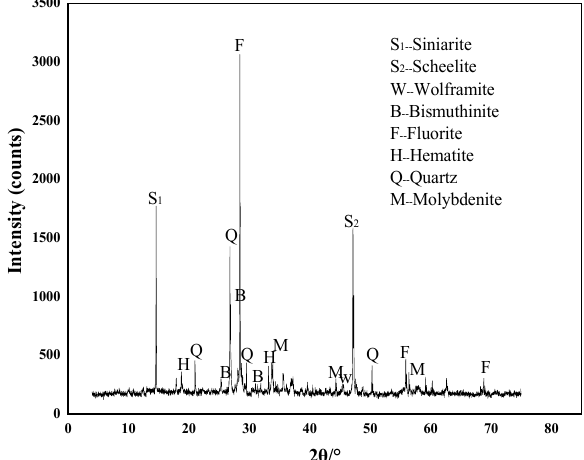
Table 1. Chemical compositions of tungsten ores (wt/%).